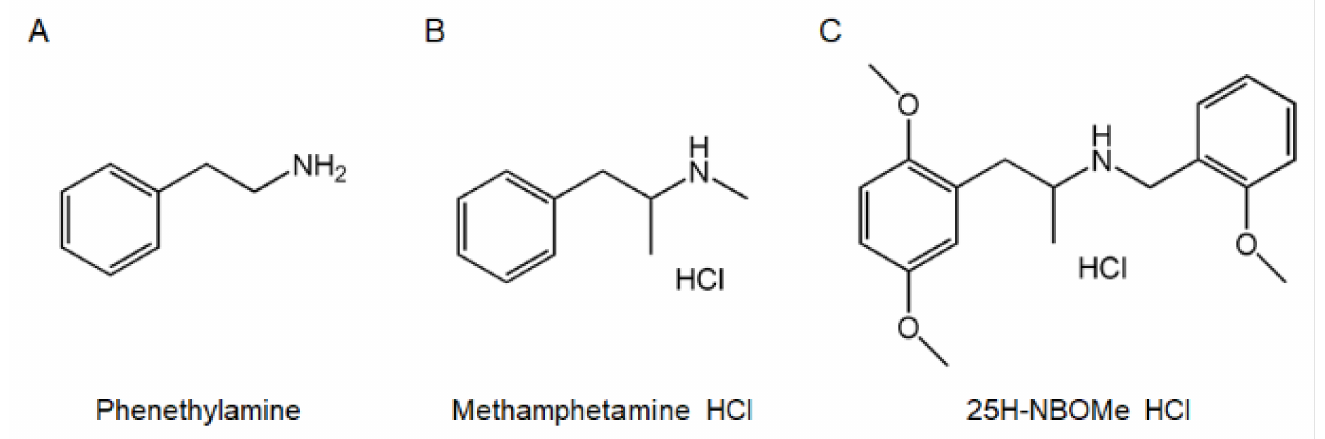
Figure 1. Chemical structures of phenethylamine ( A ), methamphetamine HCl ( B ), and 25H-NBOMe HCl ( C